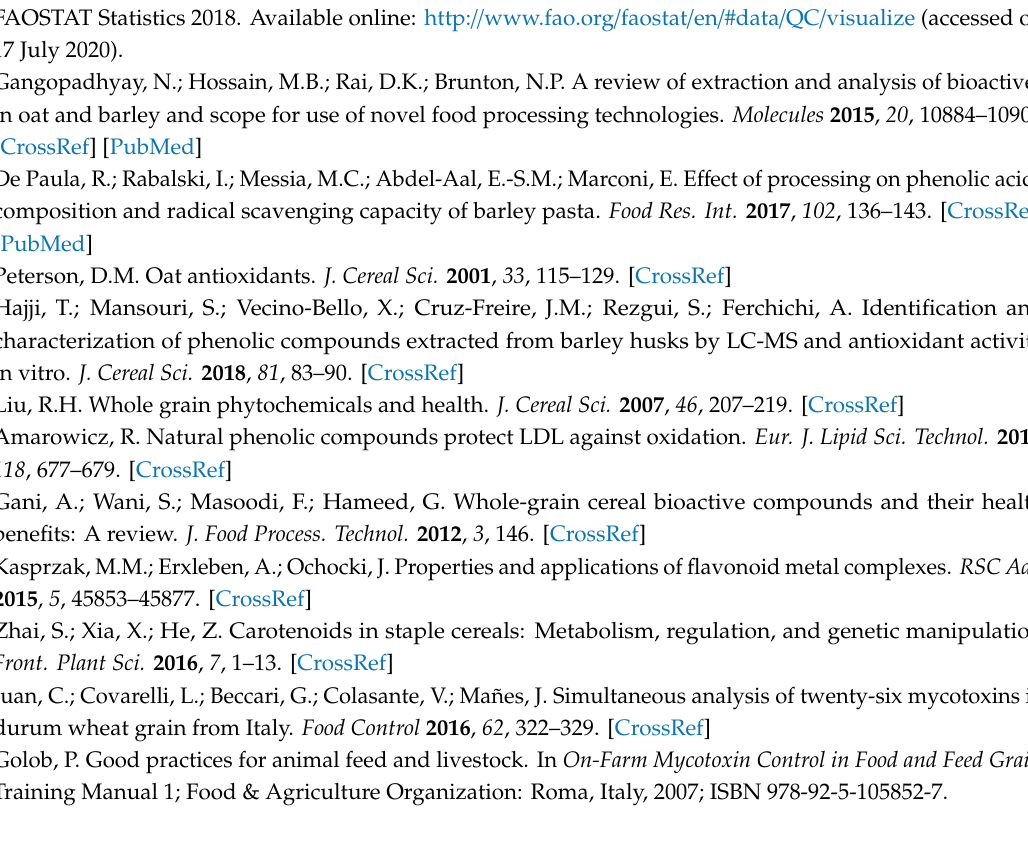
Table S1: Multiple reaction monitoring (MRM) transitions with retention times, ion ratio, declustering potential, collision energy and cell exit potential used to detect target mycotoxins using a single method with negative and positive